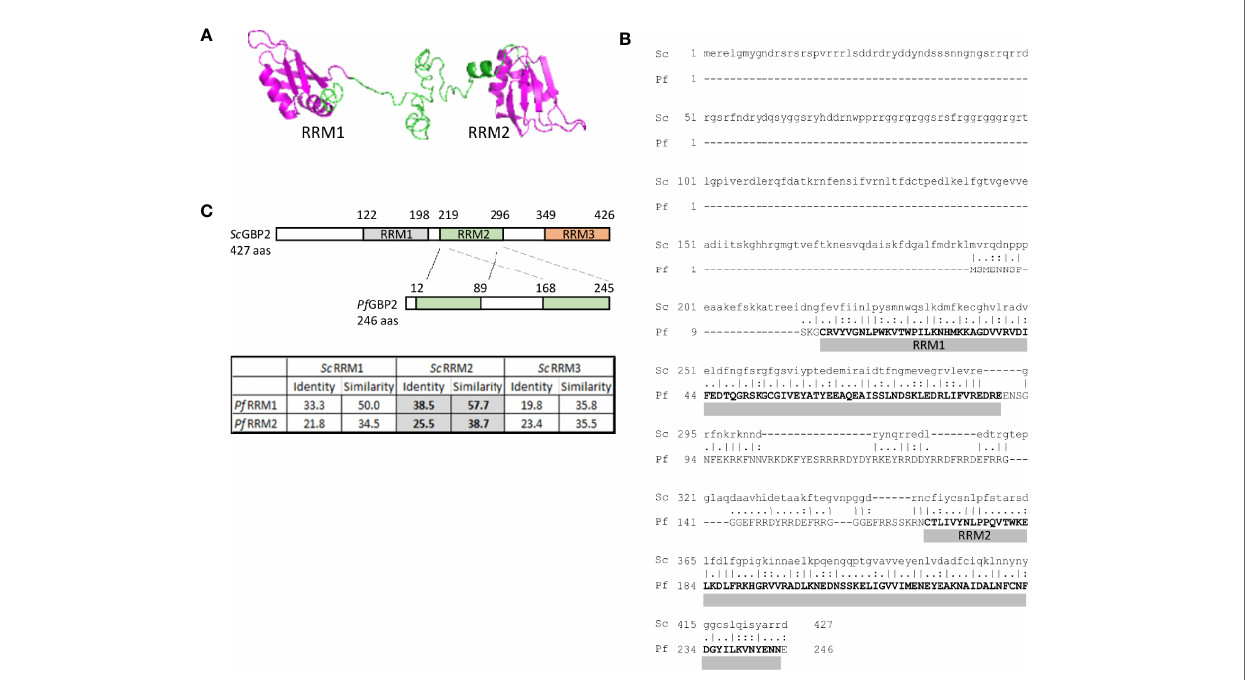
Pf GBP2. Table shows amino acid identity and similarity scores from pairwise alignments of the individual RRM domains: grey highlighted boxes show that both RRM domains from Pf GBP2 score most highly against Sc GBP2